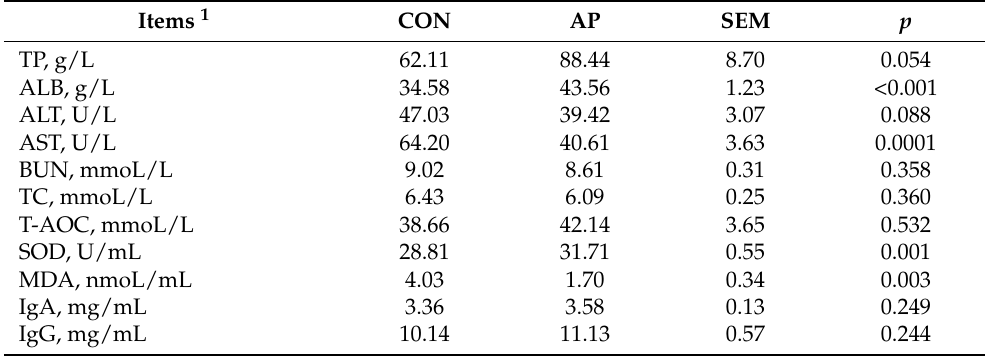
Table 4. Effects of fermented AP (apple pomace) on blood biochemical, blood antioxidant capacity and immune indicators of weaned